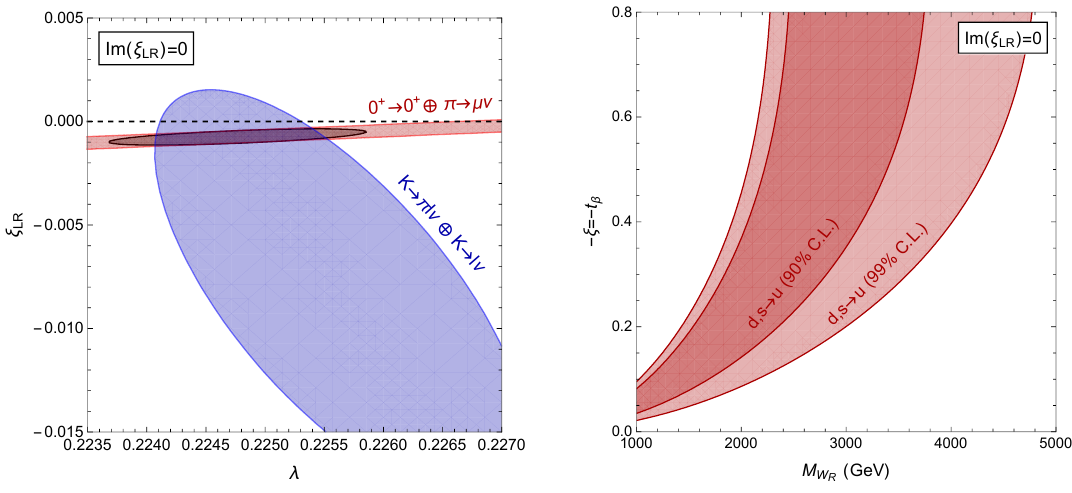
Figure 5 . The left panel depicts the λ − ξ LR plane, with constraints at 90% C.L. ( ∆ χ 2 = 4 . 6 ) from kaon decays in blue, those from 0 + → 0 + and pion decays in red, and the combination in black. The right panel shows the preferred region at 90% and 99% C.L. projected onto the M while allowing the SM CKM parameter λ to vary. Both panels assume Im ( ξ